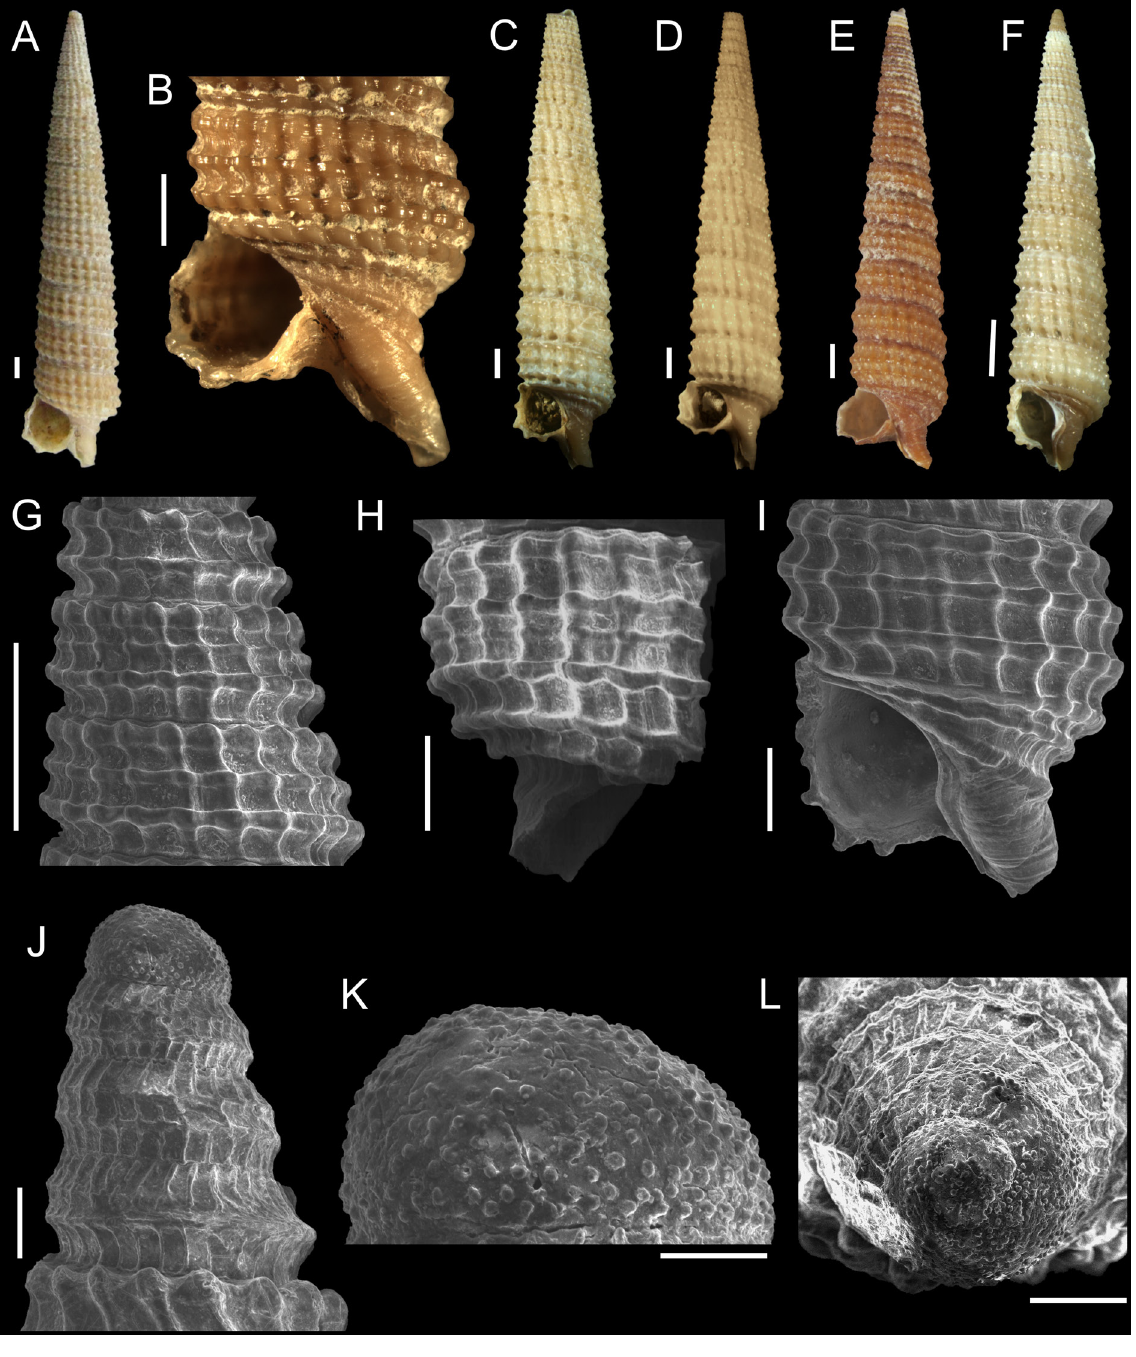
Fig. 2. Eutriphora auffenbergi Rolán & Lee, 2008. A–B . FLMNH 419186, holotype, 21.8 mm. C . MNRJ 32390*, 16.00 mm. D . MNRJ 32611*, 15.28 mm. E . MZSP 110920,